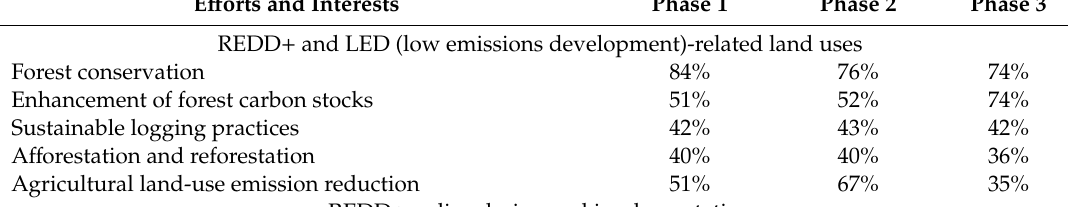
Table 3. Overall e ff orts and interests in REDD + . MRV: monitoring, reporting, and verification. E ff orts and